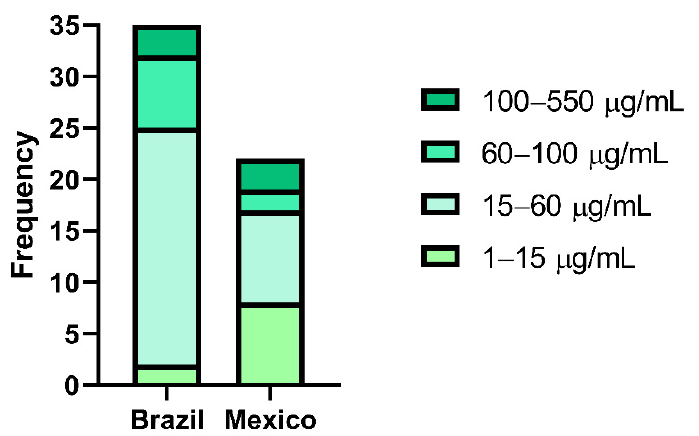
Figure 8. Anticancer activity of propolis from Brazil and Mexico. Distribution of the half-maximal Inhibitory Concentrations found in the 16 Brazilian propolis studies and the 5 Mexican propolis studies utilized. Frequency: number of times a IC50 was found in that interval.